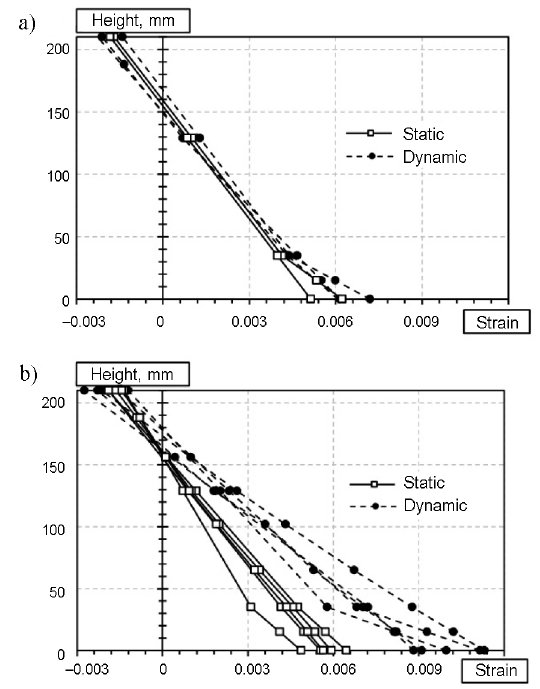
Fig. 10. Concrete strains at the cross-section of the rail seat: a) new sleepers; b) used